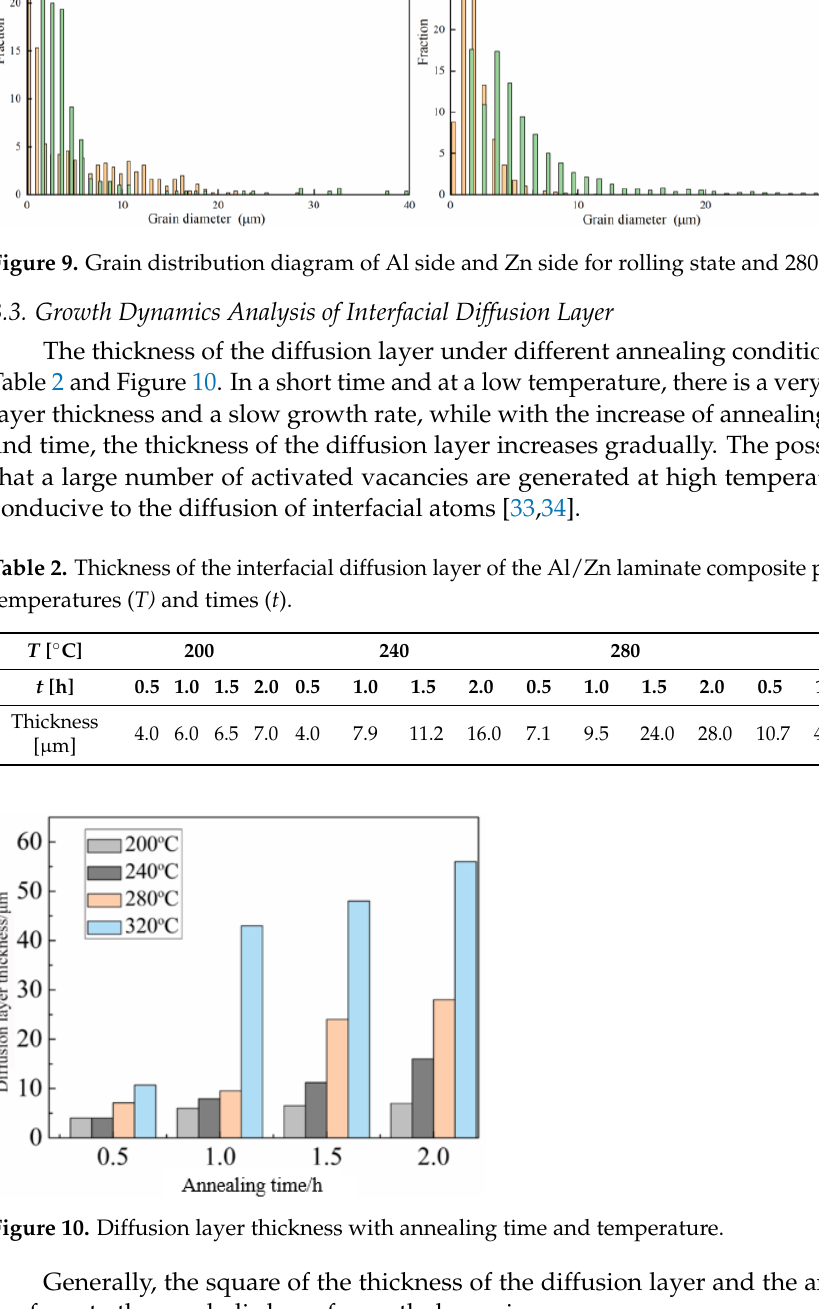
Figure 10. Diffusion layer thickness with annealing time and temperature.